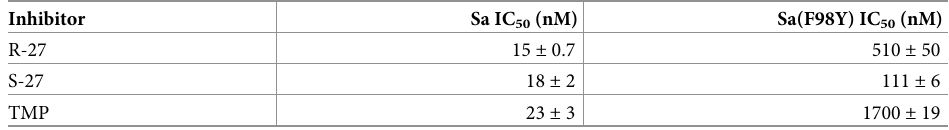
Table 1. IC 50 data for R-27, S-27 and TMP. Adapted from Table 2 in Ref.